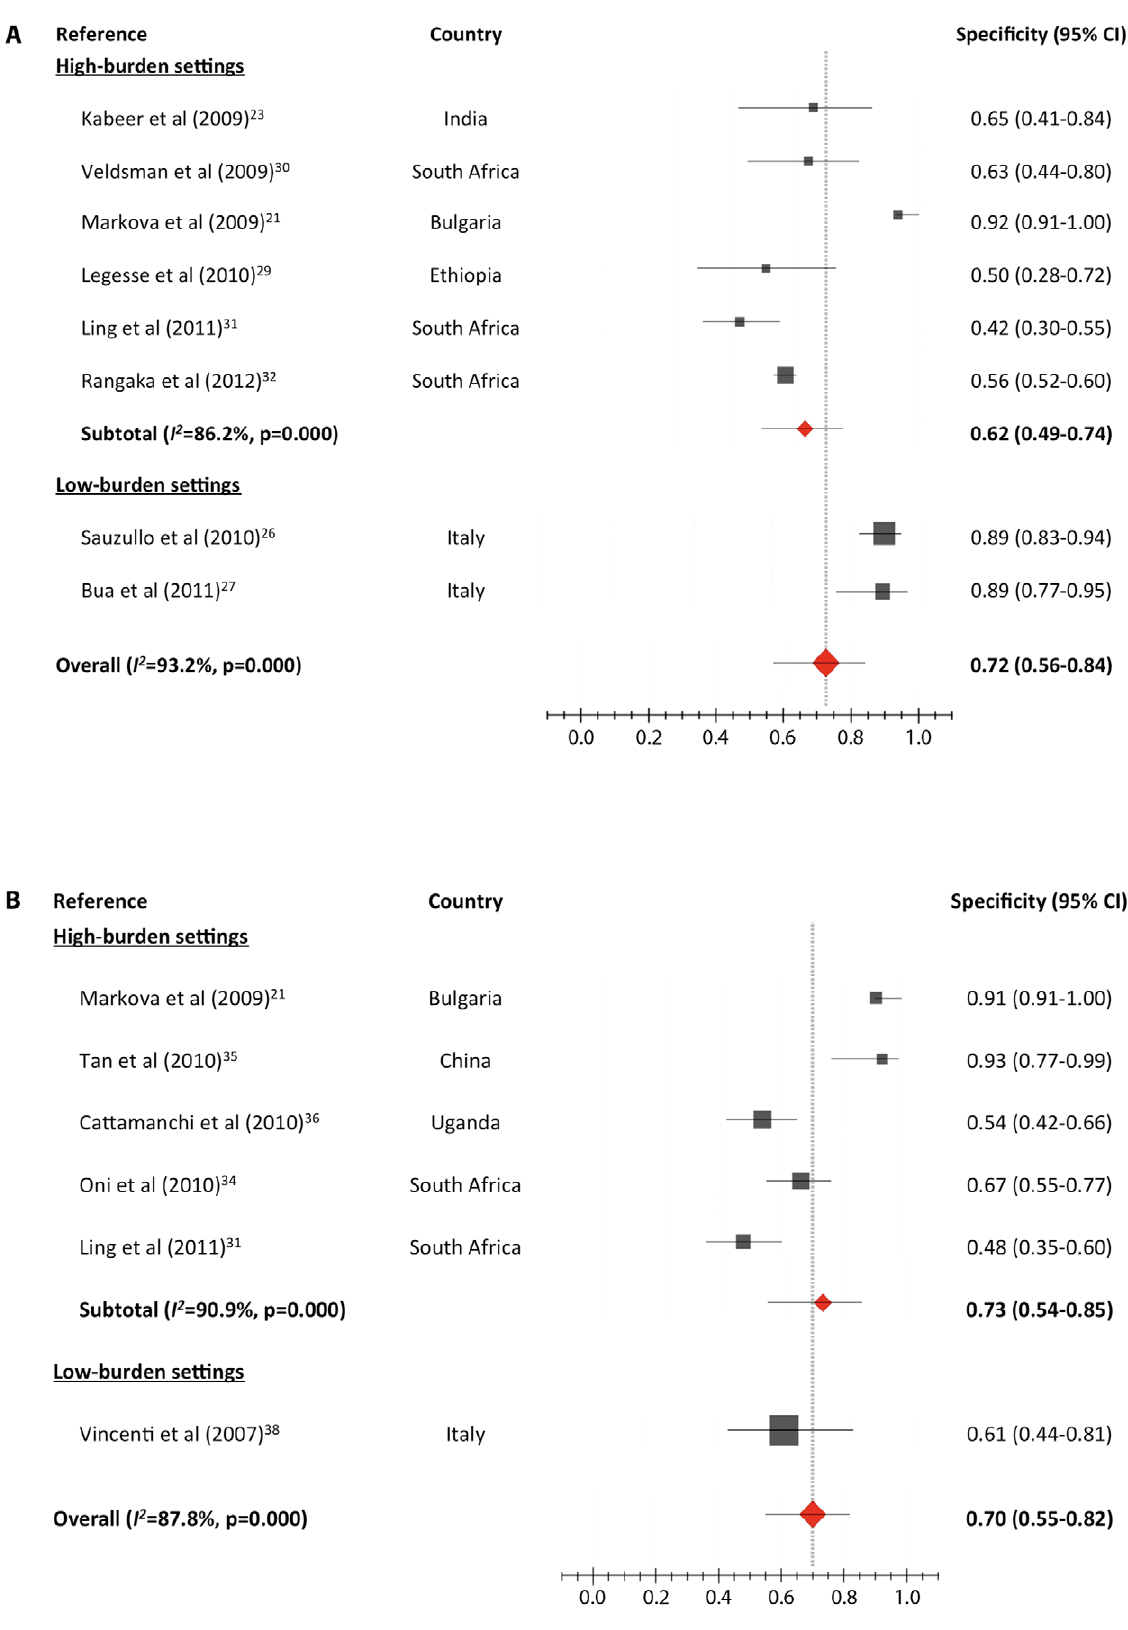
Figure 3. Specificity of QuantiFERON-TB Gold In-Tube (A) and T.SPOT.TB (B), in HIV-infected patients with confirmed tuberculosis, stratified for tuberculosis burden setting. Pooled estimates derived from random effects (DerSimonian-Laird) modeling.